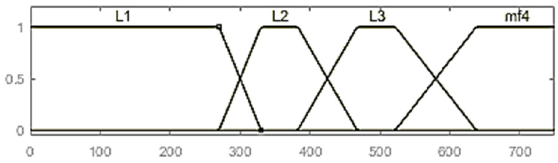
Figure 12. Input membership functions for C 2 H 4 .